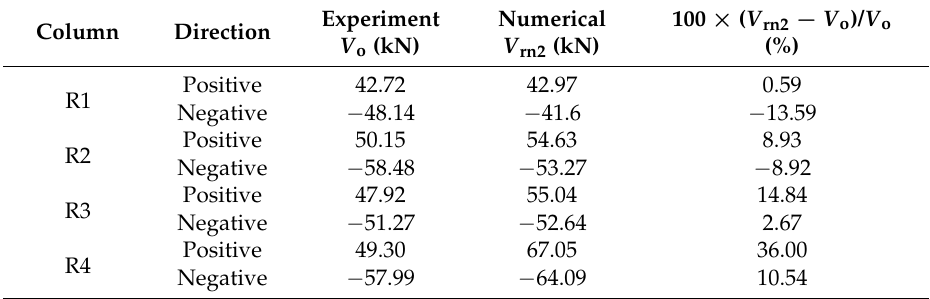
Comparison of experimental and numerical maximum lateral strengths for four repaired